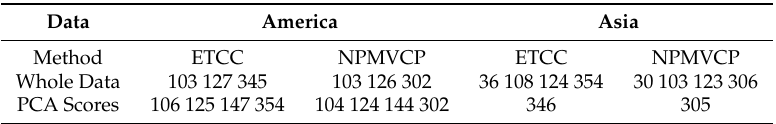
Table 19. Change point detection by ETCC and NPMVCP with real exchange currency data of America (1/3/2013 to 10/3/2014) and Asia (1/4/2013 to 10/6/2014).